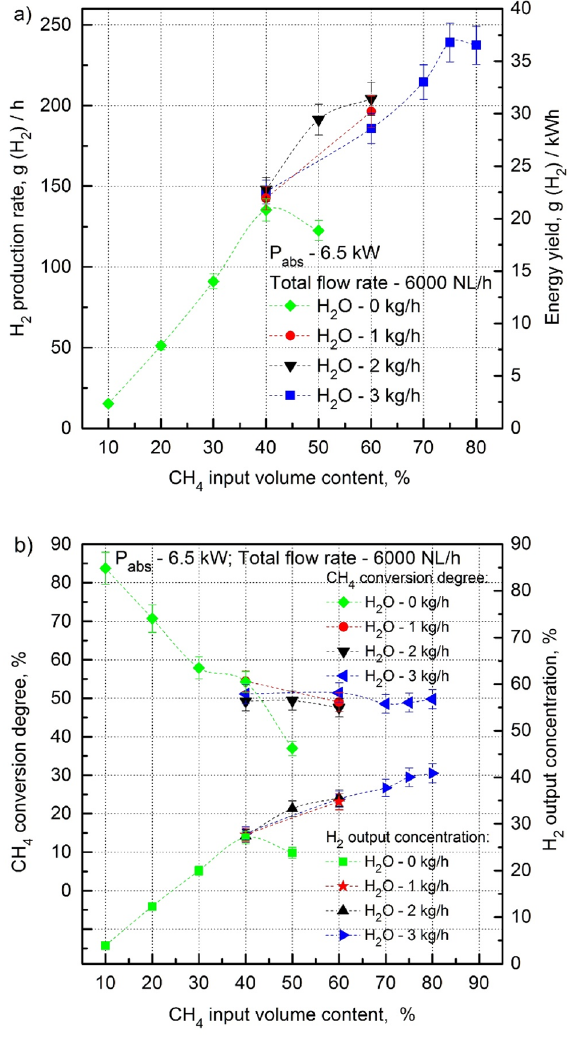
Figure 4. H 2 production rate, energy yield ( a ), CH 4 conversion degree and H 2 output concentration ( b ) as a function of the CH 4 input volume content in the CH 4 :CO 2 mixture for various H 2 O steam consumption rates (P abs —6.5 kW, total flow rate—6000 NL/h). The green measuring points (green diamond; green square) correspond to the dry reforming of the CH 4 :CO 2 mixture